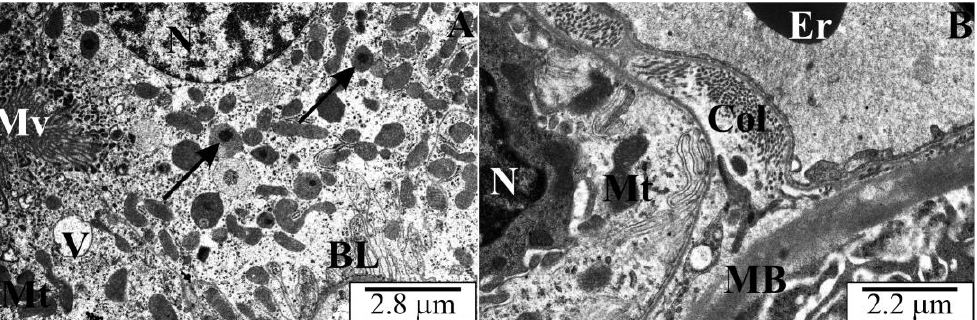
Figure 6. ( A , B ) Electronograms of renal cortical sections of rats transplacentally infected with B . microti . BL—a basal labyrinth of the proximal tubule, N—cell nuclei proximal tubule, Er—erythrocyte, Col—collagen fibers, MB—basement membrane, Mt—mitochondria, Mv—microvilli, V—vacuole, arrows—peroxisomes.